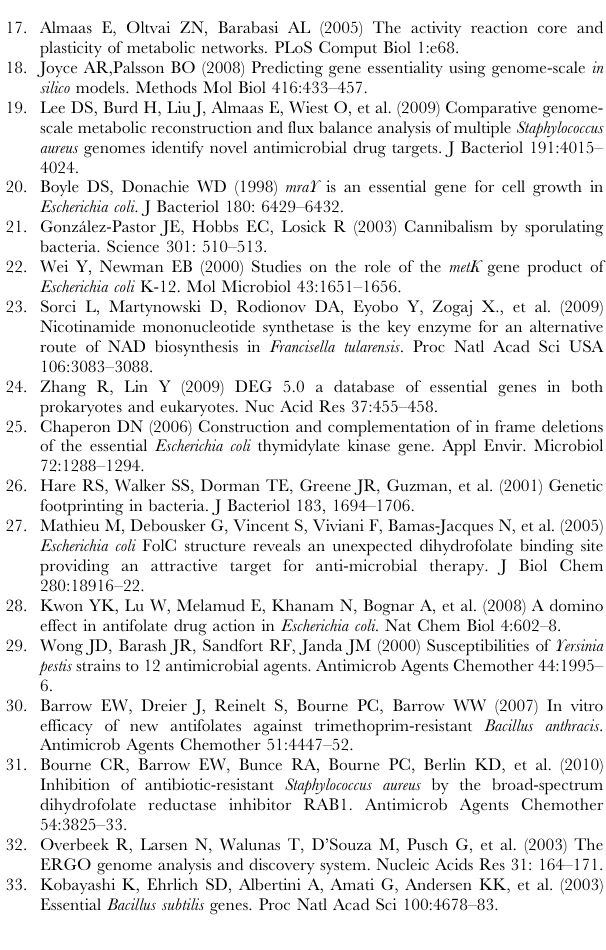
Table S1 Metabolic essential enzymes and their gene identifiers of the individual strains of Category A